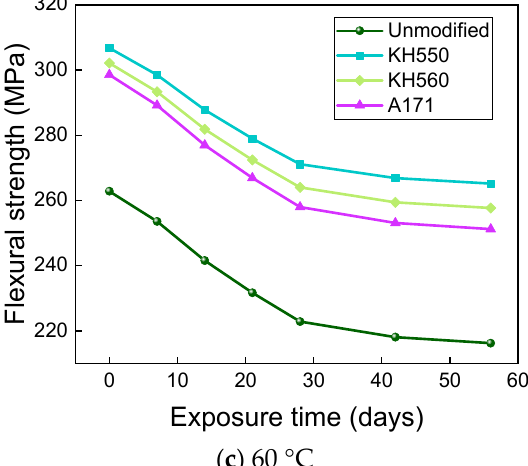
Figure 23. Flexural strength in a 10% NaCl high-concentration seawater environment.